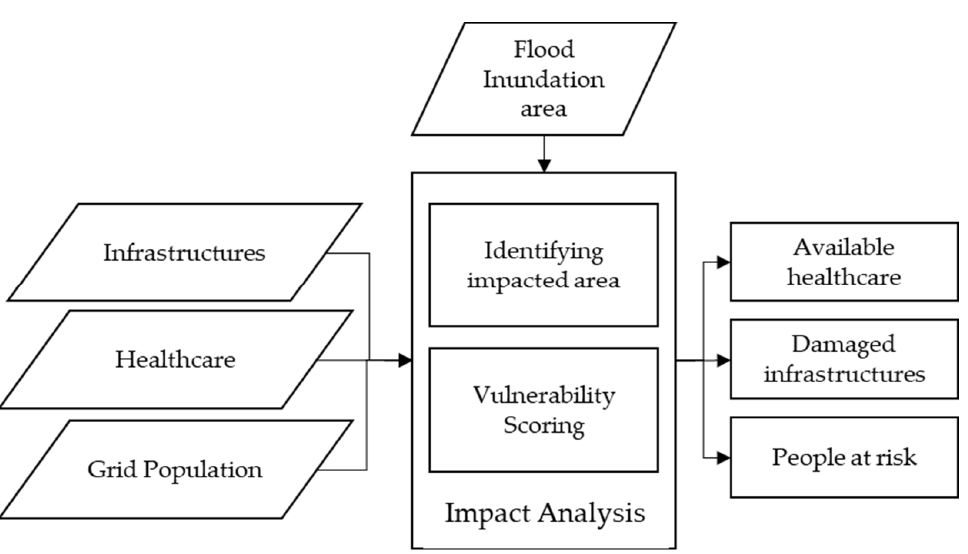
Figure 2. Impact analysis procedure.